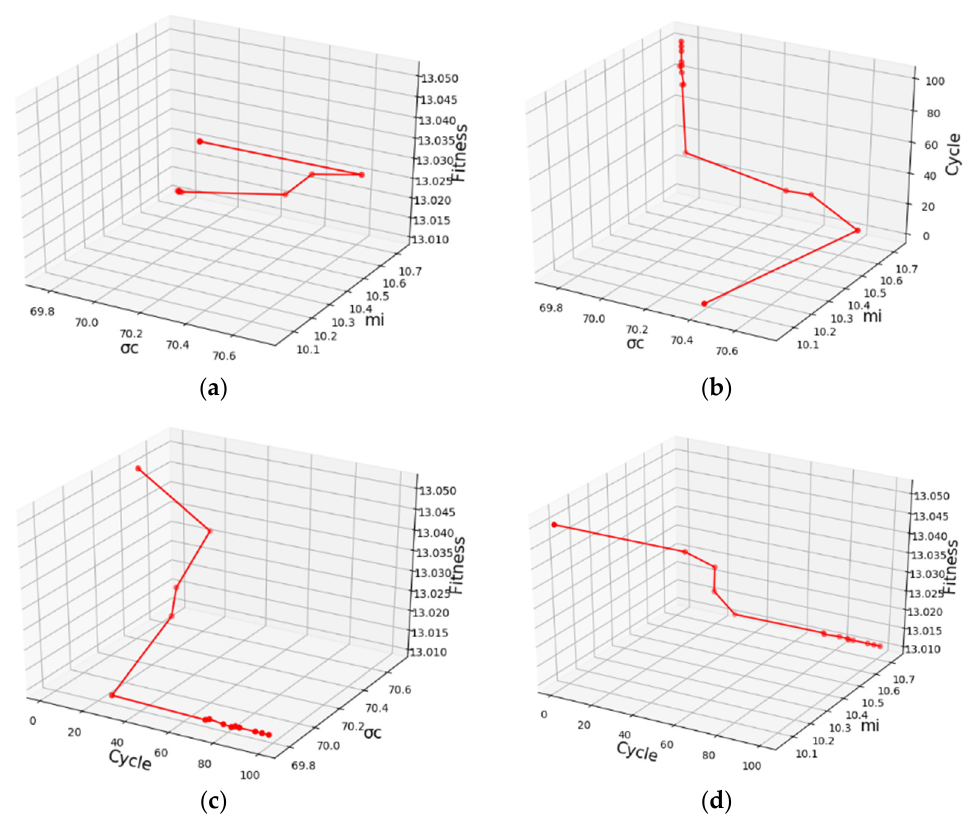
Figure 9. The searching process of the parameters of the failure criterion: ( a ), σ c , m i , and fitness; ( b ) σ c , m i , and cycle; ( c ) σ c , cycle, and fitness; ( d ) cycle, m i , and fitness.